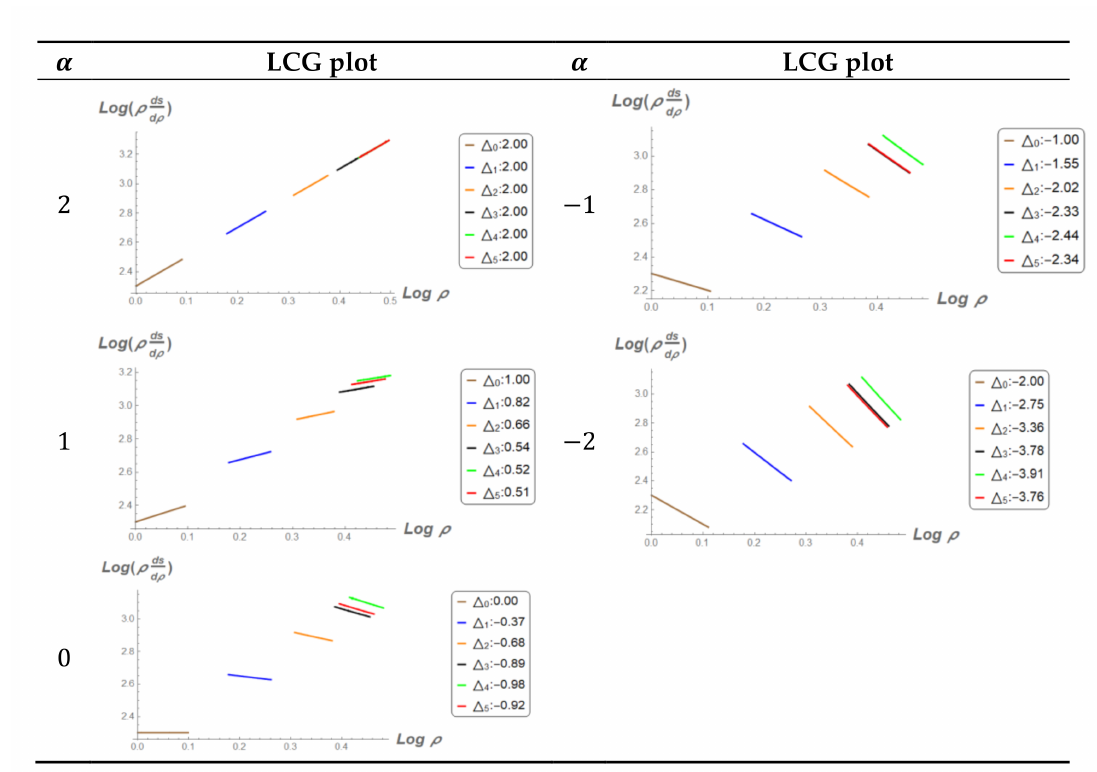
Figure 8. LCG plot of LoCs in maximum principal direction on LA swept surfaces for 𝛼 = 2 (left) and 𝛼 = −1 (right).